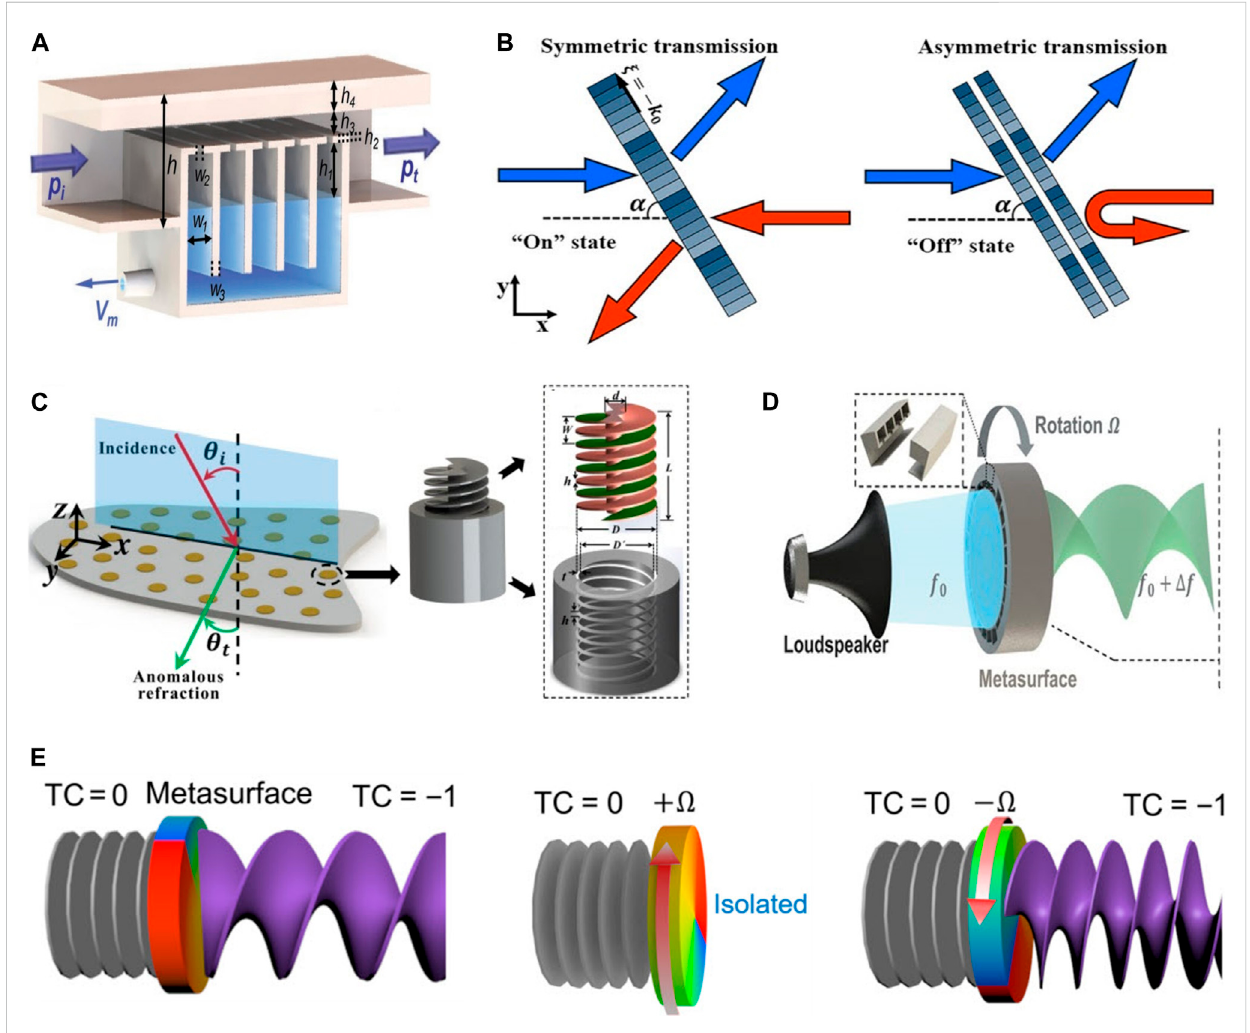
FIGURE 2 Examplesofmechanicaltuning. (A) Mechanismofprogrammableacousticmetasurfacecomposedofastraightchanneland fi veshuntedHelmholtz resonators (Tian et al., 2019). (B) Controllable acoustic asymmetric transmission with an adjustable gap distance (Liu and Jiang, 2018). (C) Tunable metasurface design based on the screw and nut mechanism (Zhao et al., 2018). (D) Schematic of frequency convertor by rotation. The frequency of the acoustic wave will be converted to a new frequency after passing through a speci fi cally designed rotating metasurface (Wang et al., 2022a). (E) Schematic diagram of the static condition without the rotational Doppler effect (left). When the metasurface and the vortex rotate in the same